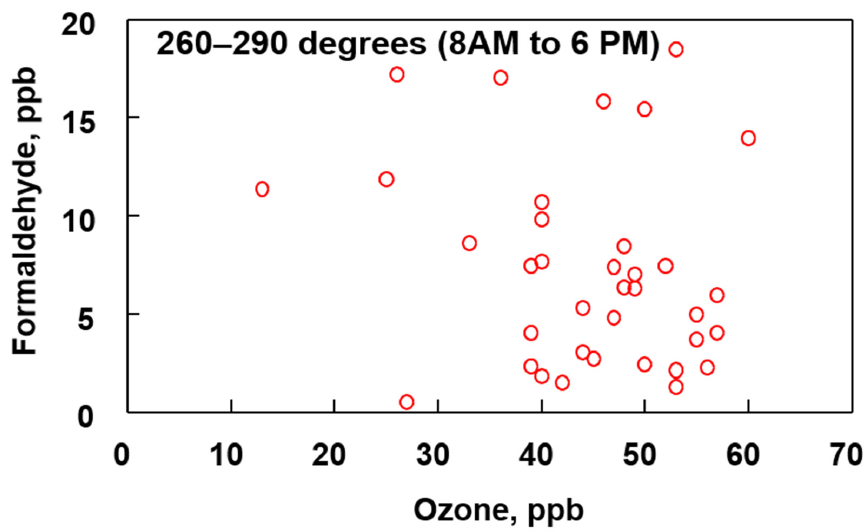
Figure 11. Comparison of ozone and formaldehyde concentrations between the indicated wind direction and time period for the months of April, May and June (2019).